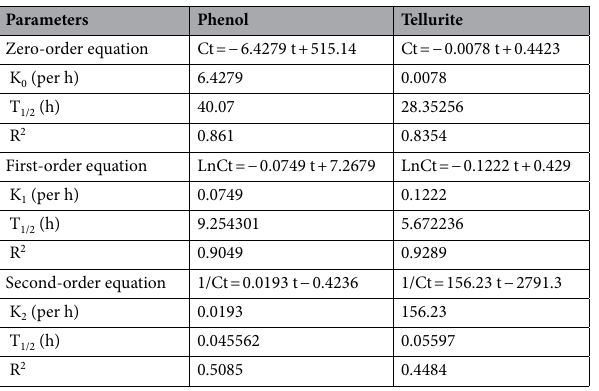
Table 2. Kinetic parameters for 500 mg/L phenol and 0.5 mM tellurite removal in separate